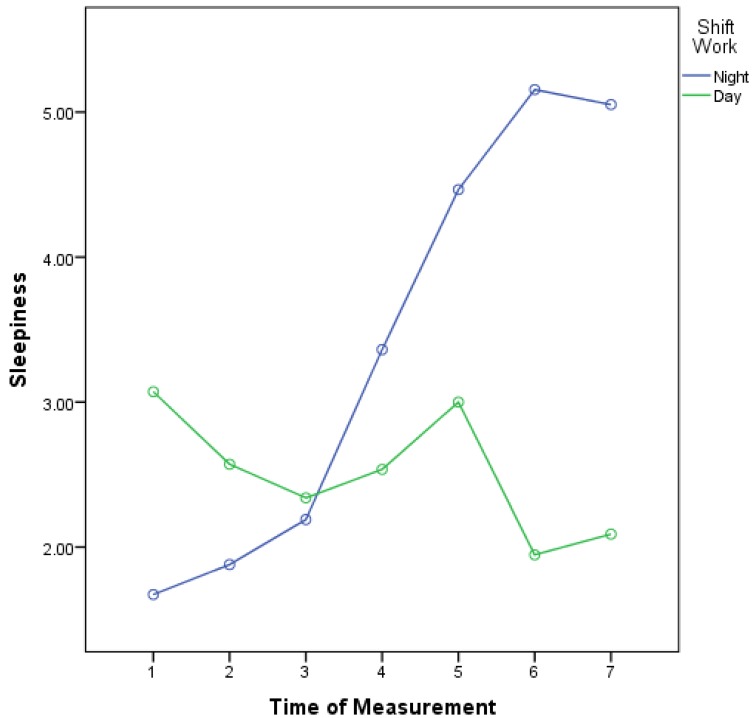
Trend of sleepiness in day-shift and night-shift workers over seven consecutive segments of the work shift.